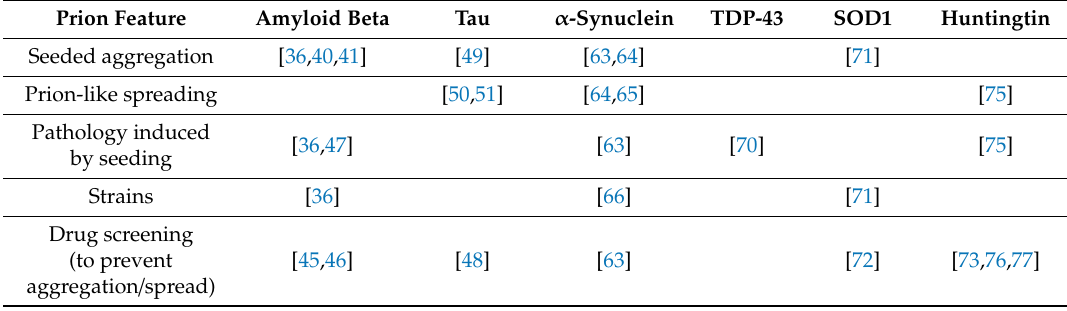
Table 2. Overview of organotypic slice culture studies which have used the prion-like features of aggregate-prone proteins from other neurodegenerative